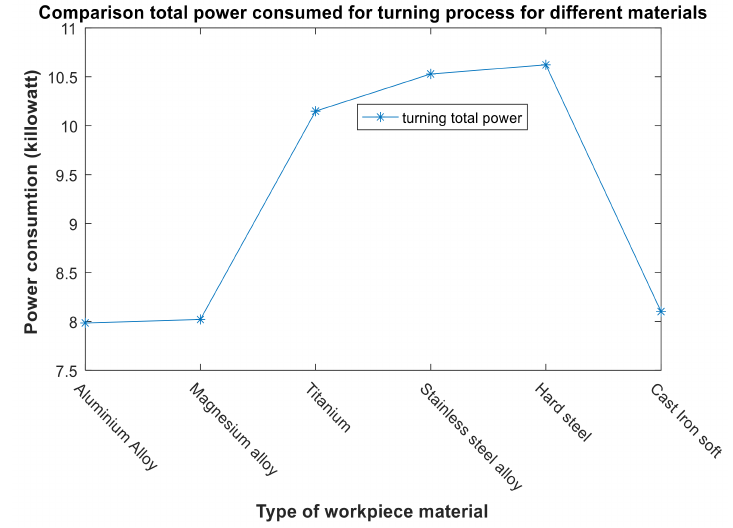
Figure 11. Comparison of total power consumed for turning processes for different material.